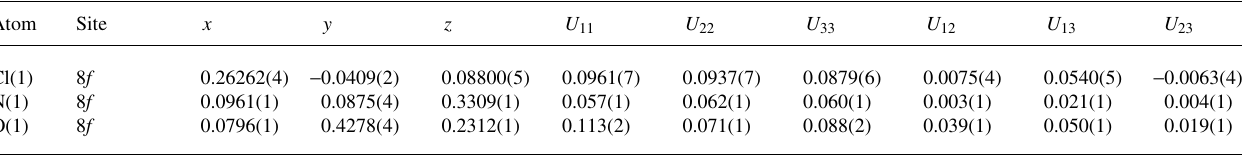
Table 3. Atomic coordinates and displacement parameters (in Å 2 )